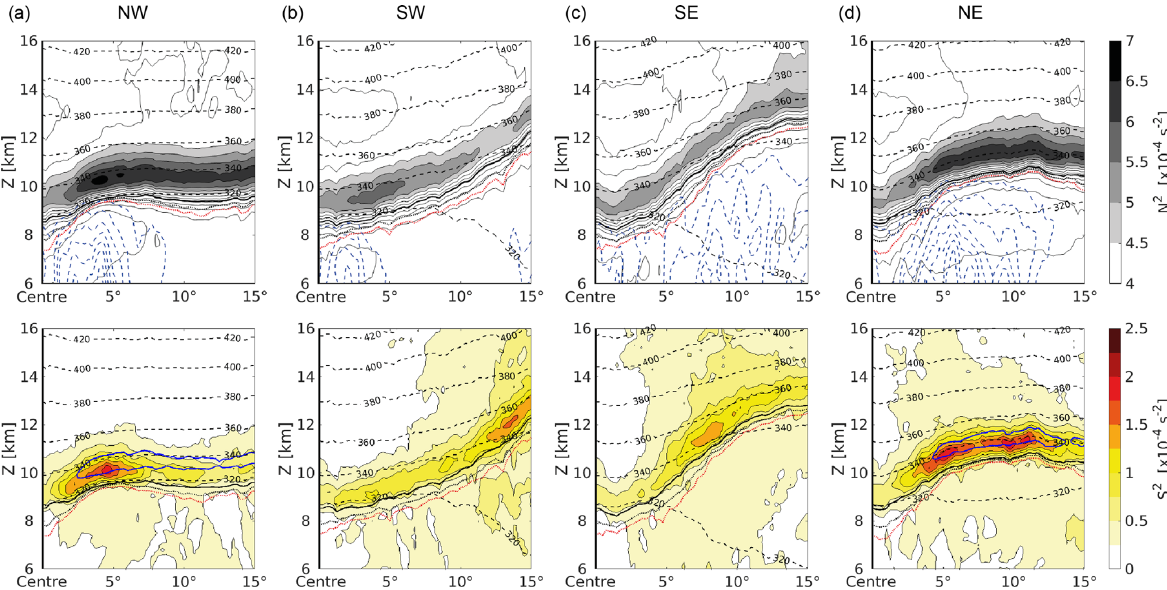
Figure 12. Composites of flow features for the 76 strong cyclones with p msl , min ≤ 990hPa at the point in time of maximum intensity. Vertical tropopause-based averaged cross section composites, reaching from the cyclone centre (a) northwestward, (b) southwestward, (c) southeast- ward and (d) northeastward. Top row shows static stability N 2 and cloud ice water content as in Fig. 9, bottom row shows wind shear S 2 as in Fig. 10b. The orientation of the vertical cross sections is indicated by the black arrows in Fig.